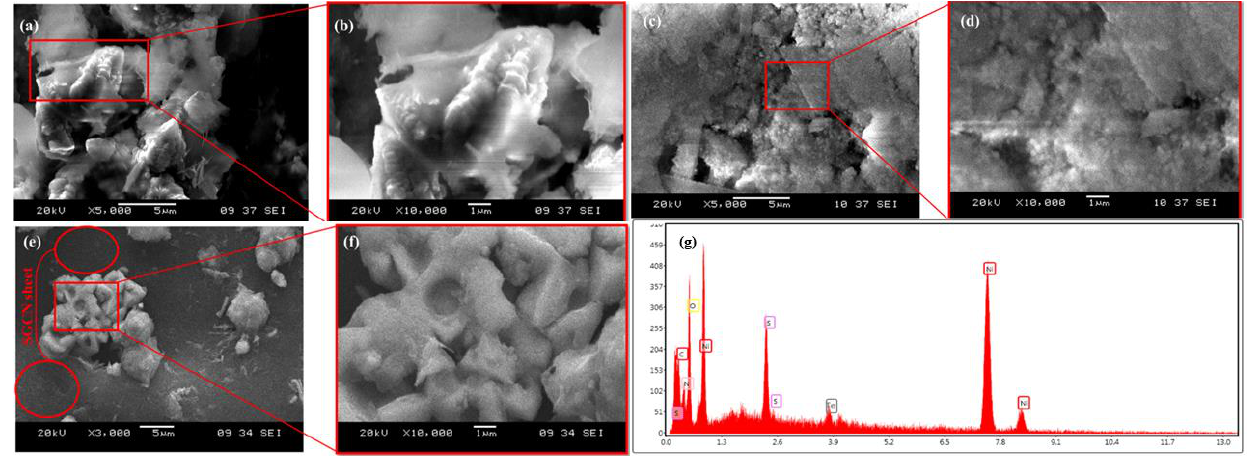
Figure 4. SEM images of ( a , b ) NiS, ( c , d ) Te@NiS, and ( e , f ) SGCN/Te@NiS. ( g ) EDX spectrum of SGCN/Te@NiS composite.